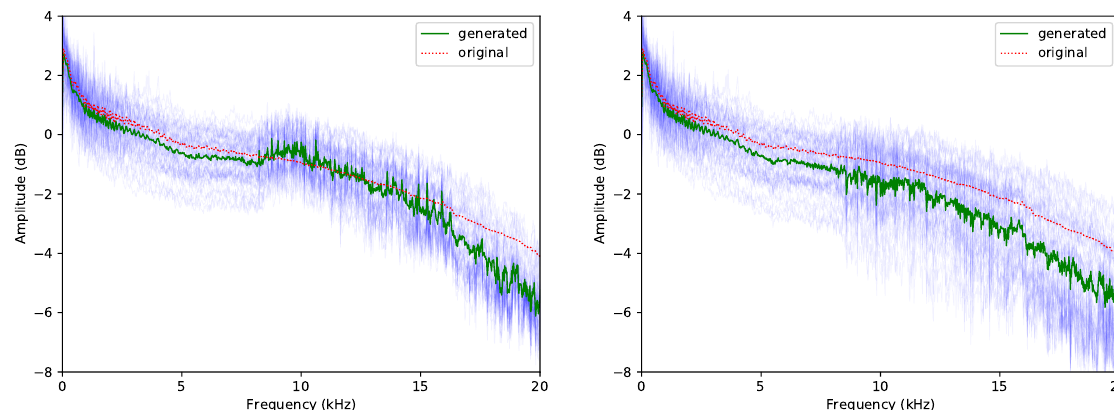
Figure 5. Frequency profiles of 50 random four-second-long excerpts from the test set (in 32 kbit/s) for different random input noise vectors z . The blue lines show the profiles of the individual samples, the green line shows the mean profile of the excerpts, and the dotted red line shows the mean of the high-quality excerpts for comparison. It becomes clear that z is strongly correlated with the energy in the upper bands and that a specific z yields a consistent overall